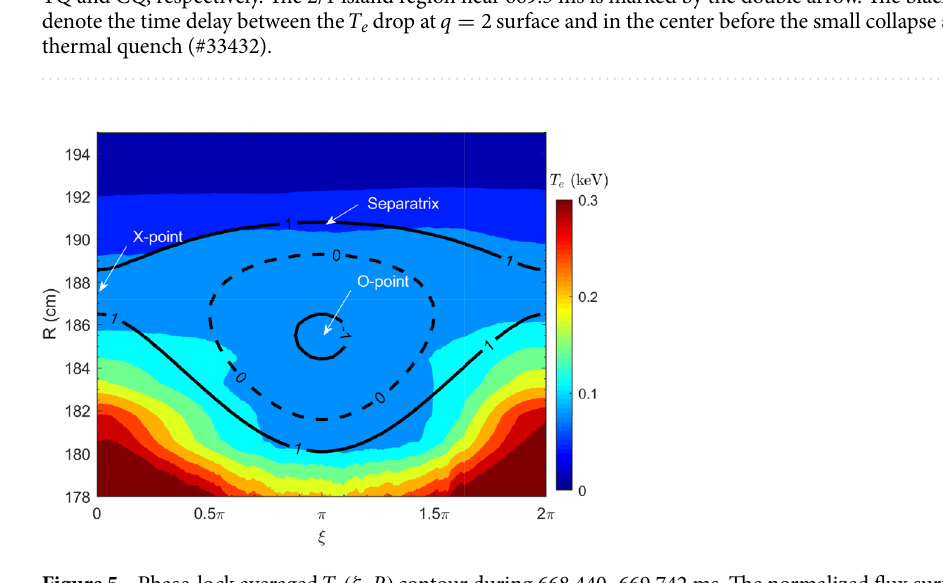
Figure 5. Phase-lock averaged T e (ξ , R ) contour during 668.440–669.742 ms. The normalized flux surface labels at (cid:31) = − 1 (O-point), 0 and 1 (separatrix) are depicted with black curves